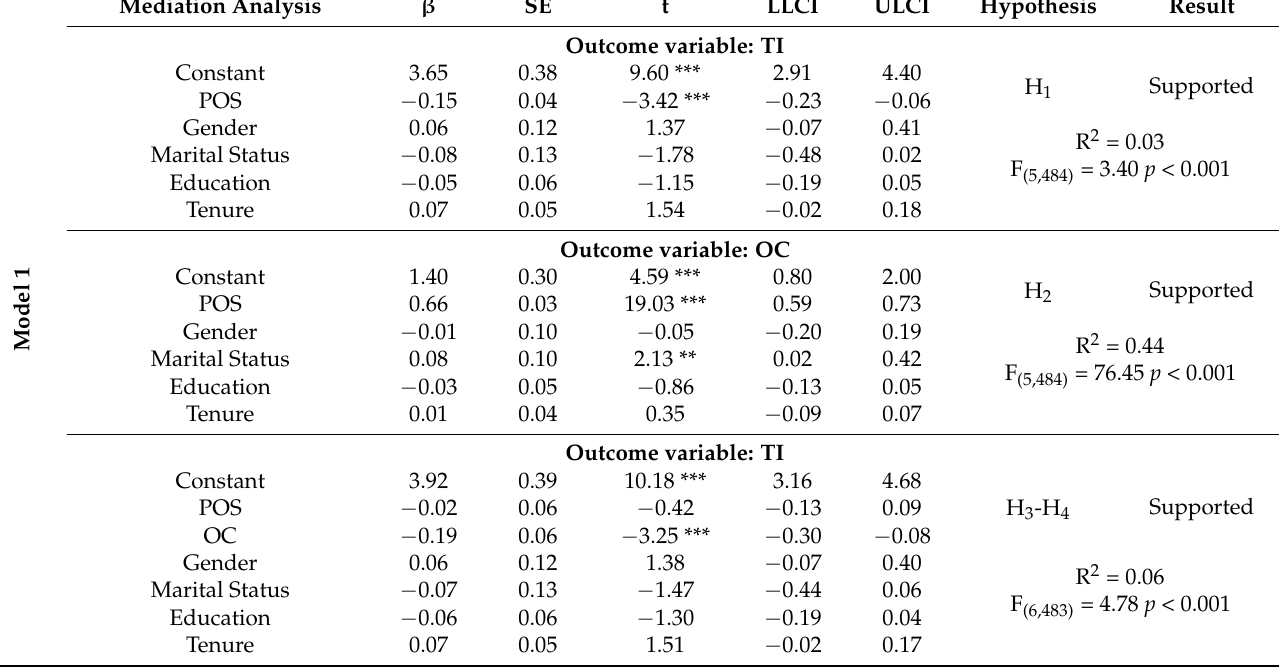
Table 5. Results of testing the